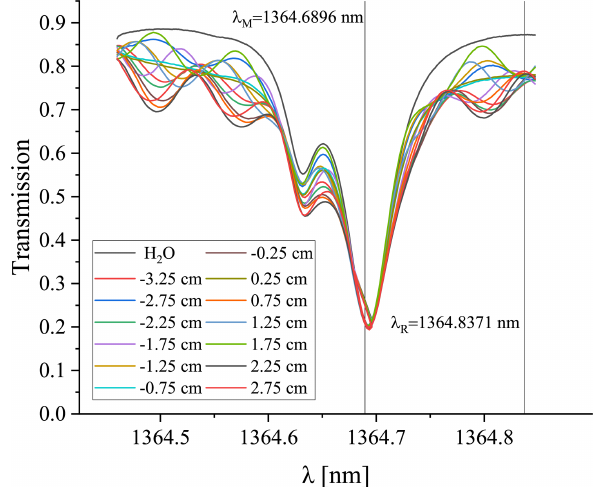
(λ,x) of the win- Figure 6. Effective transmission spectra T (g+l) L dows and laboratory air ( n l = 2 . 93 × 10 17 cm − 3 ) for the measure- ments across the long dimension at various positions x compared (λ) of the laboratory air only. with the transmission spectrum T (l) L Node-like features are observed on both sides of the transmission minimum. One of them is located close to λ R